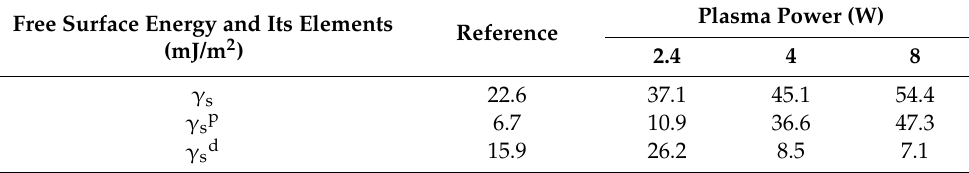
Table 5. Free surface energy and its elements for PP (depending on plasma